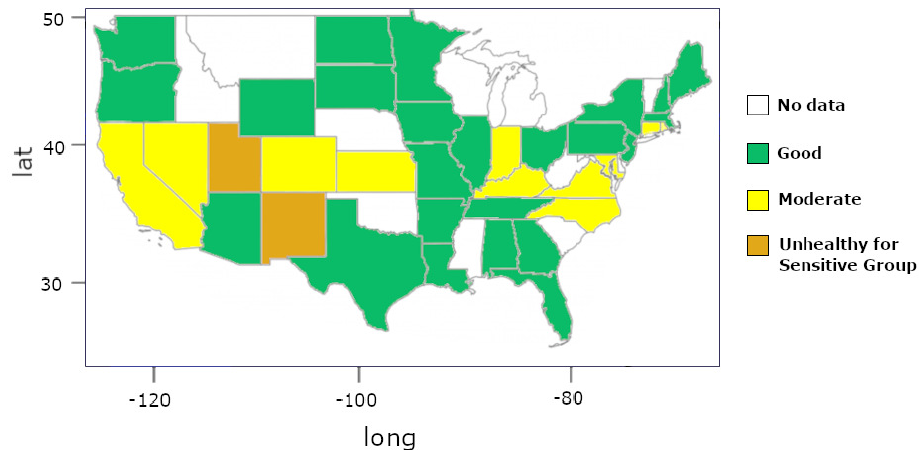
Figure 12. O 3 AQI peer state in the United States in 2015 using classical statistics (average); the colors in the map follow the definitions in Table 4, and white means that the area does not have data information.